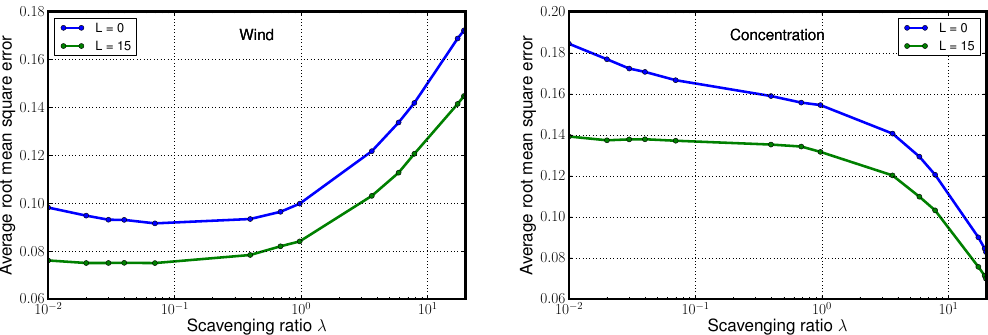
Figure 6. Average filtering analysis RMSEs of the wind variables (left) and concentration variables (right) of the L95-T, as a function of the scavenging ratio for the ensemble transform EnKF (IEnKS with L = 0) and the IEnKS with L =